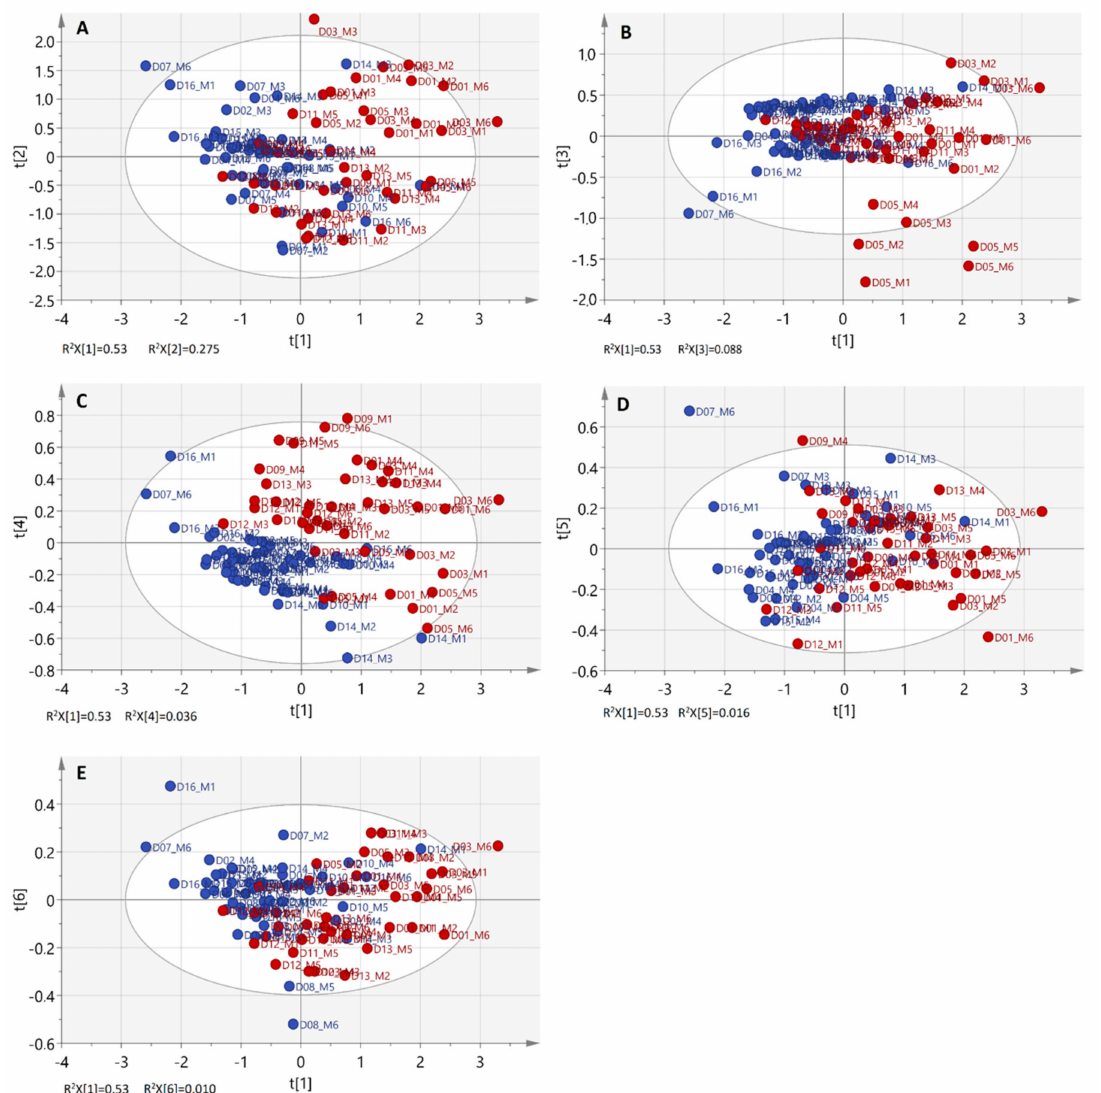
Figure 2. Scatterplots of principle component analysis (PCA) scores (t) along the first and second ( A ), third ( B ), fourth ( C ), fifth ( D ) or sixth ( E ) principal components extracted from the pre-processed dataset of 88 reference bay laurel EOs (obtained from leaves of cultivated trees in AUTh campus). • : female ( n = 8), • : male trees ( n = 7). Dot codes refer to the tree (D#) and harvest month (M#)